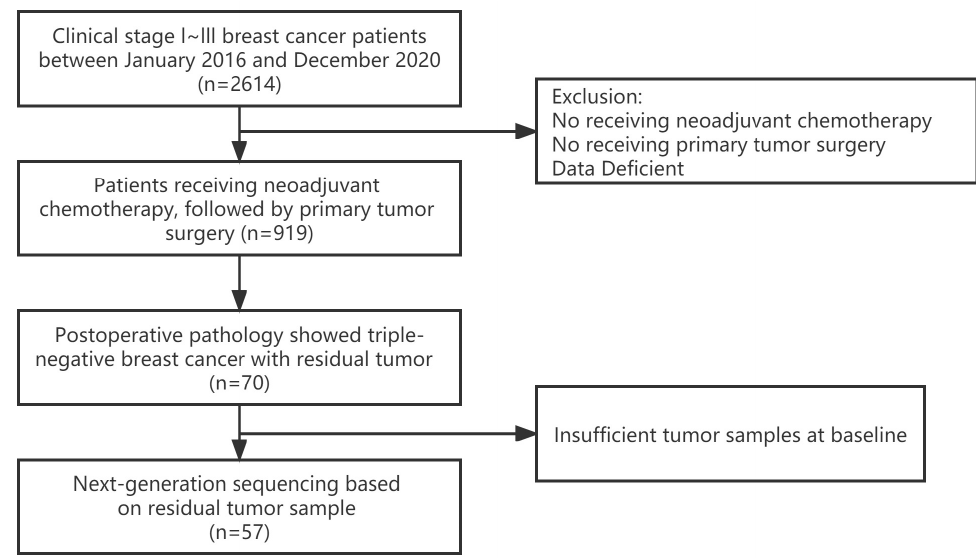
Figure 1. Flowchart of the screening procedure. Table 1. Baseline characteristics and treatment outcomes of the overall cohort and treatment sub- groups.